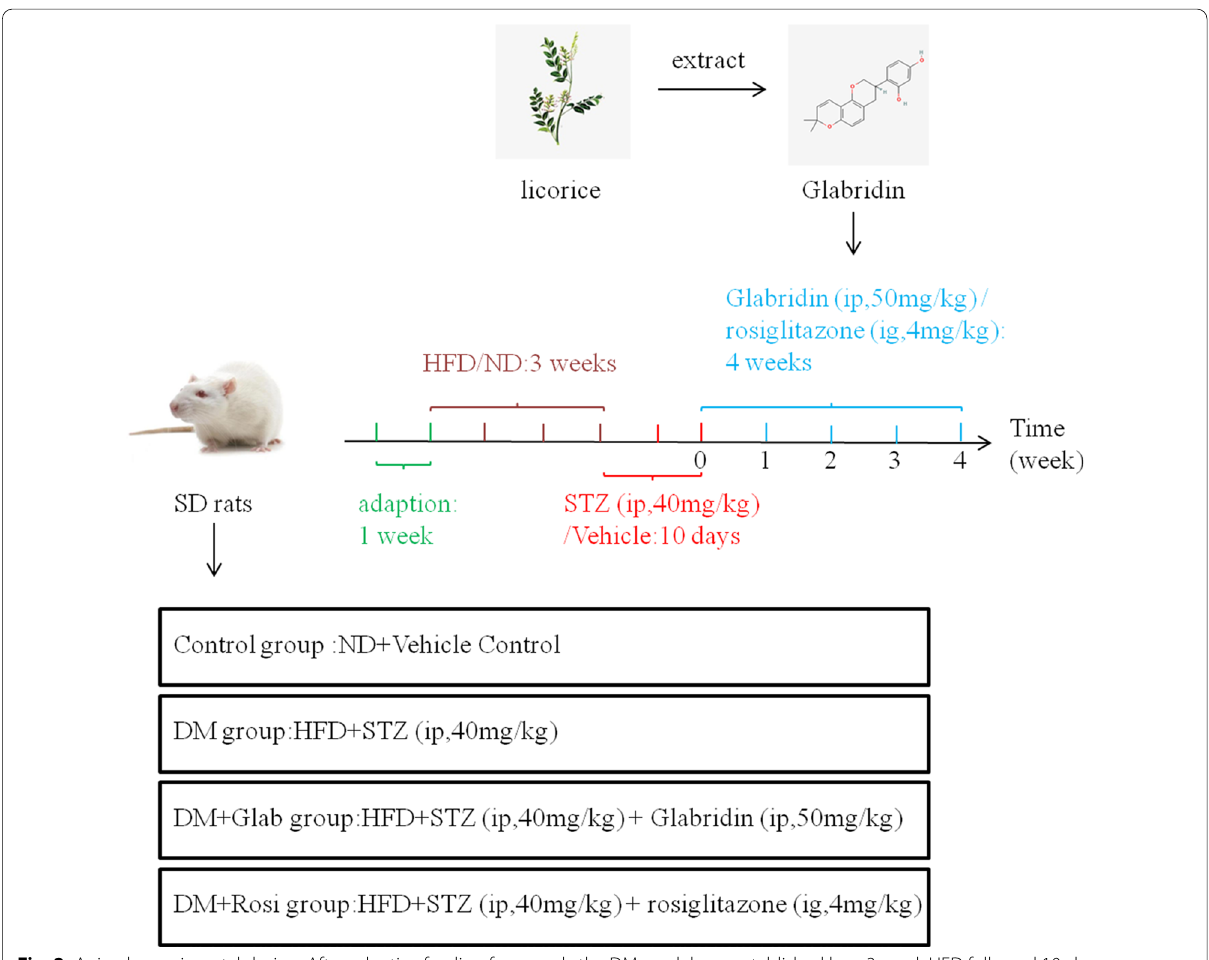
Fig. 2 Animal experimental design. After adaptive feeding for a week, the DM model was established by a 3-week HFD followed 10-days intraperitoneal injection 40 mg/kg/day STZ. The control group (n into three groups received diverse treatments: the DM group (n groups the corresponding treatments for a total of four weeks (from week 0 to week